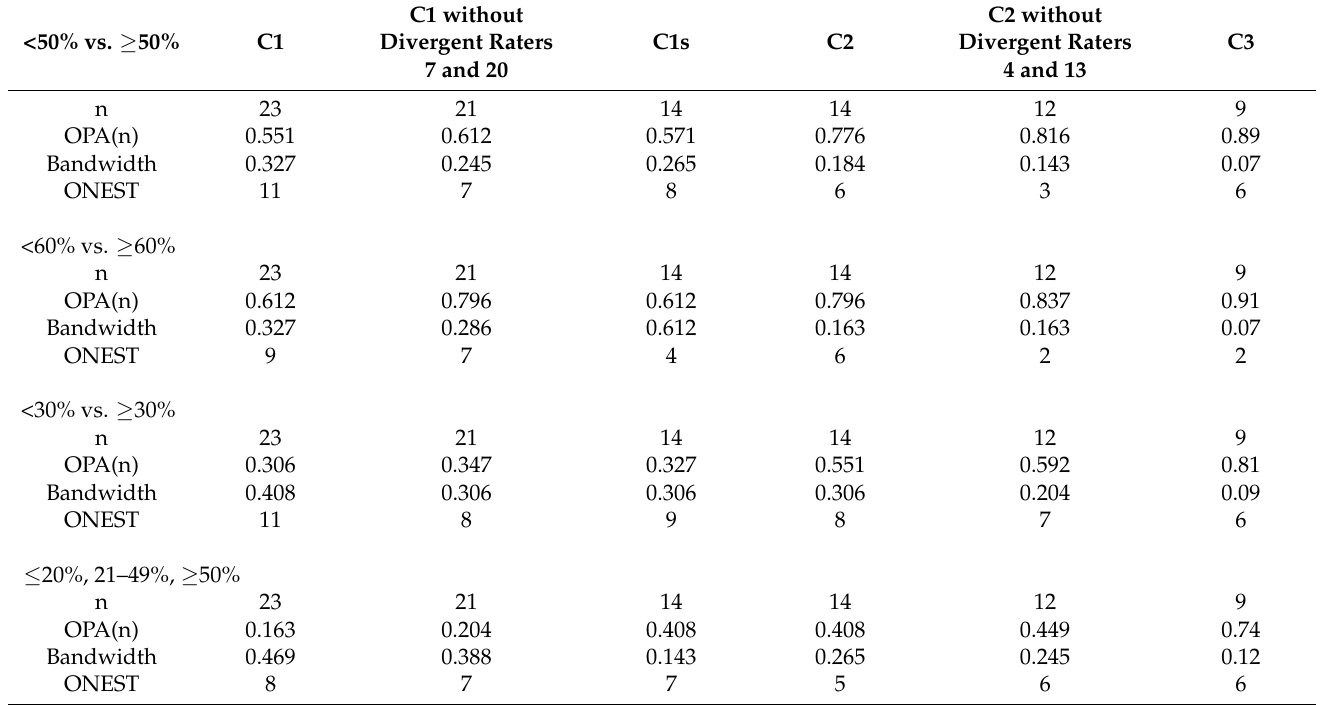
Table 1. ONEST analyses of different circulations and cut-off values of